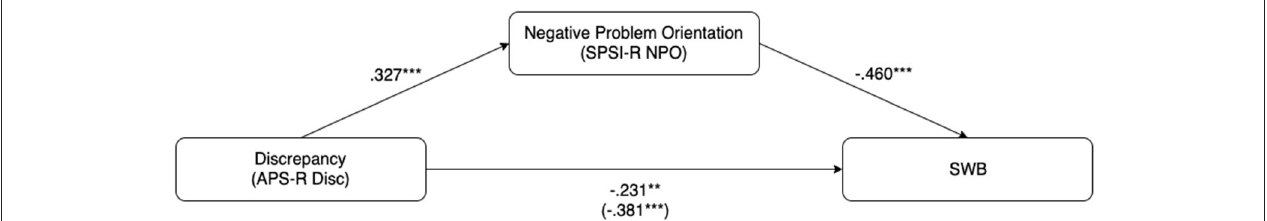
FIGURE 1 | Mediation model of the relationship between APS-R Ord and SWB with SPSI-R RPS as a mediator. ** p < 0.01 and *** p < 0.001. APS-R Ord, Almost Perfect Scale-Revised-Order subscale; SPSI-R RPS, Social Problem Solving Inventory-Revised-Rational Problem Solving; SWB, Subjective Well-being.